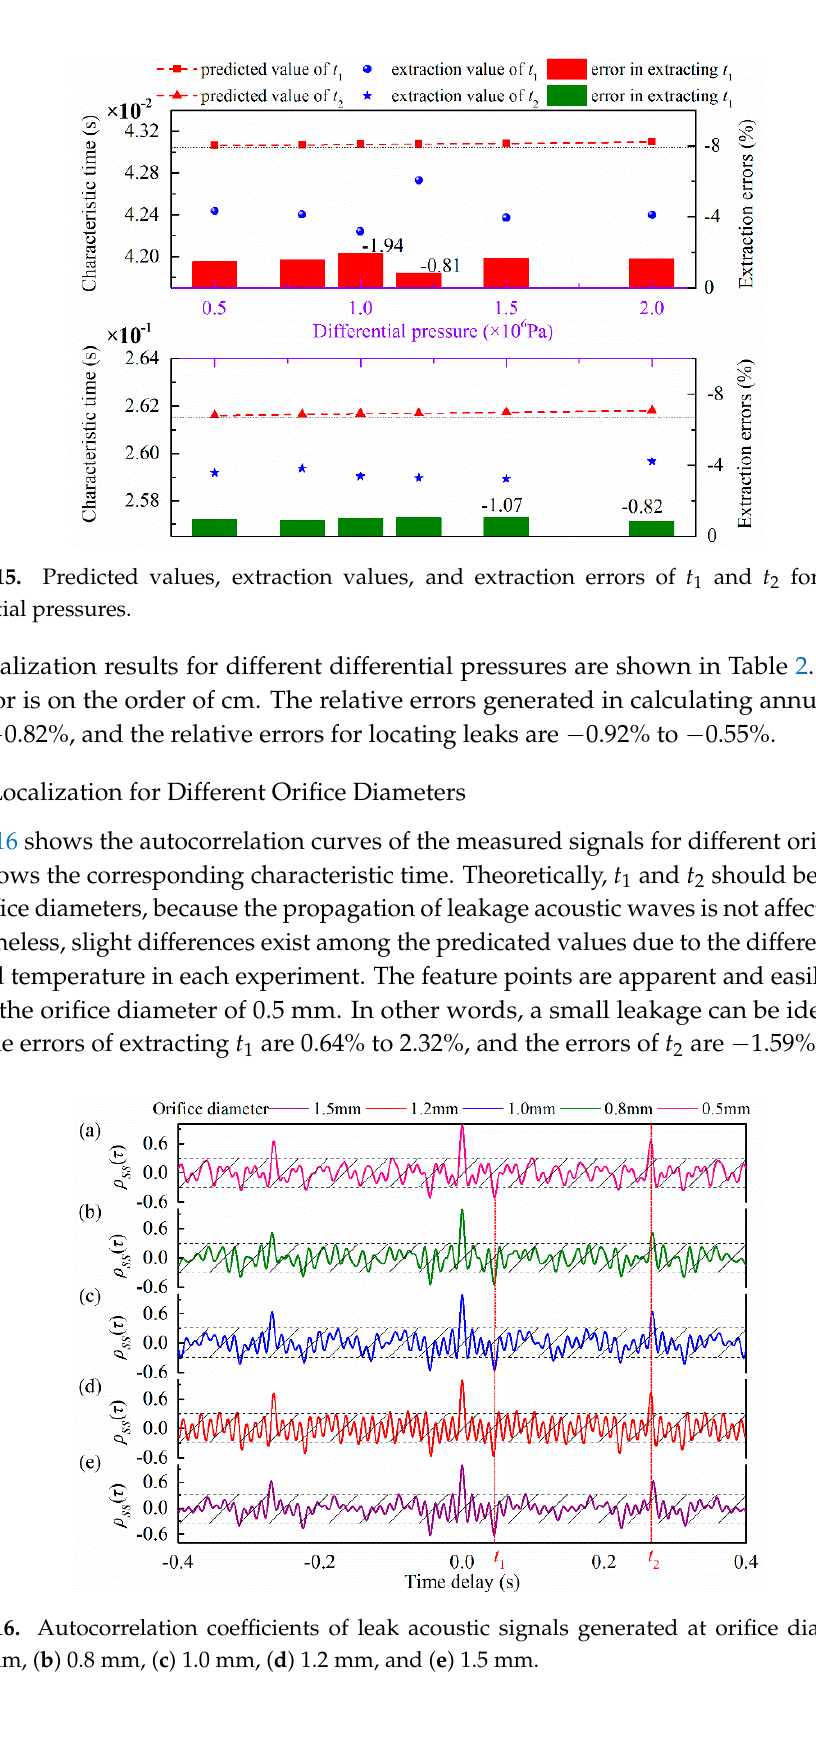
Figure 14. Autocorrelation coefficients of leak acoustic signals generated under differential pressures